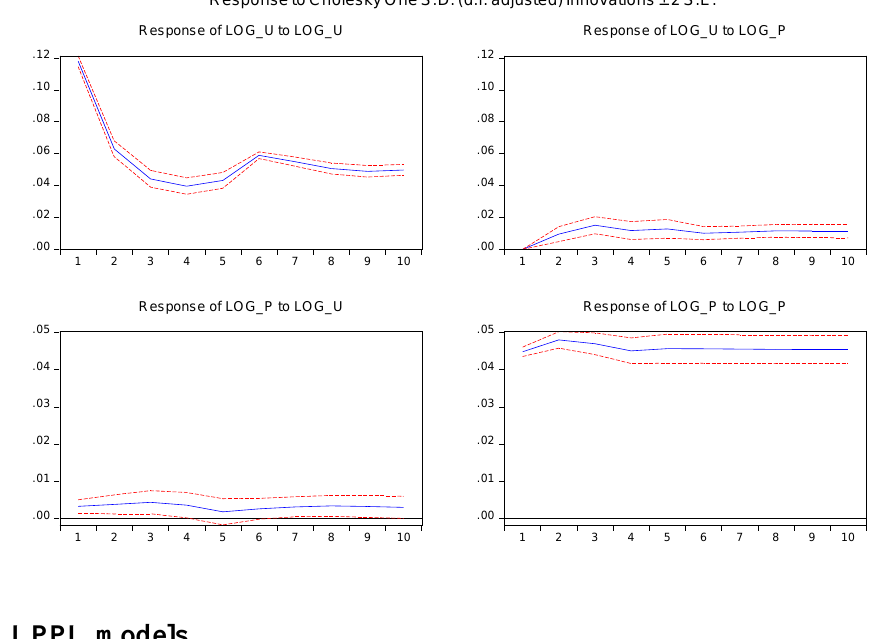
Figure 9 : Impulse Response Function for the estimated VAR